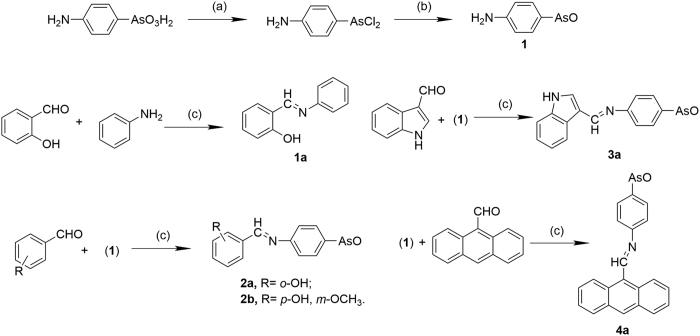
The synthesis of Schiff base derivatives.(a) concentrated hydrochloric acid and methanol (v/v: 24 mL/30 mL), catalytic amount of KI, SO2 (2 bubbles/s), RT, 30 min; (b) aqueous ammonia 10%, 0 °C, 15 min; (c) EtOH, 78–80 °C, 2–6 h, under N2.